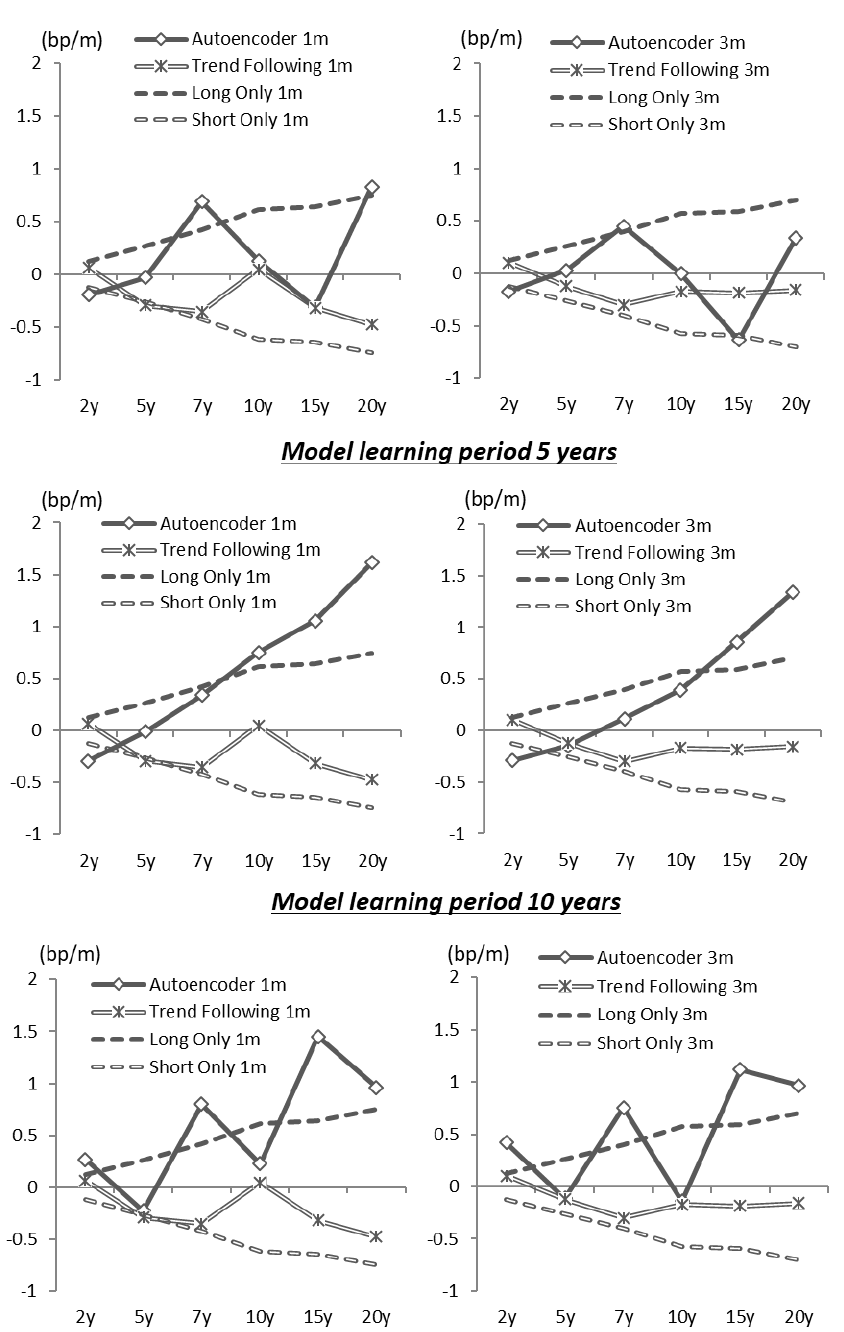
Figure 13. Average monthly capital gains based on different learning periods on a three-node hidden layer model with investment periods of 1 or 3 months.